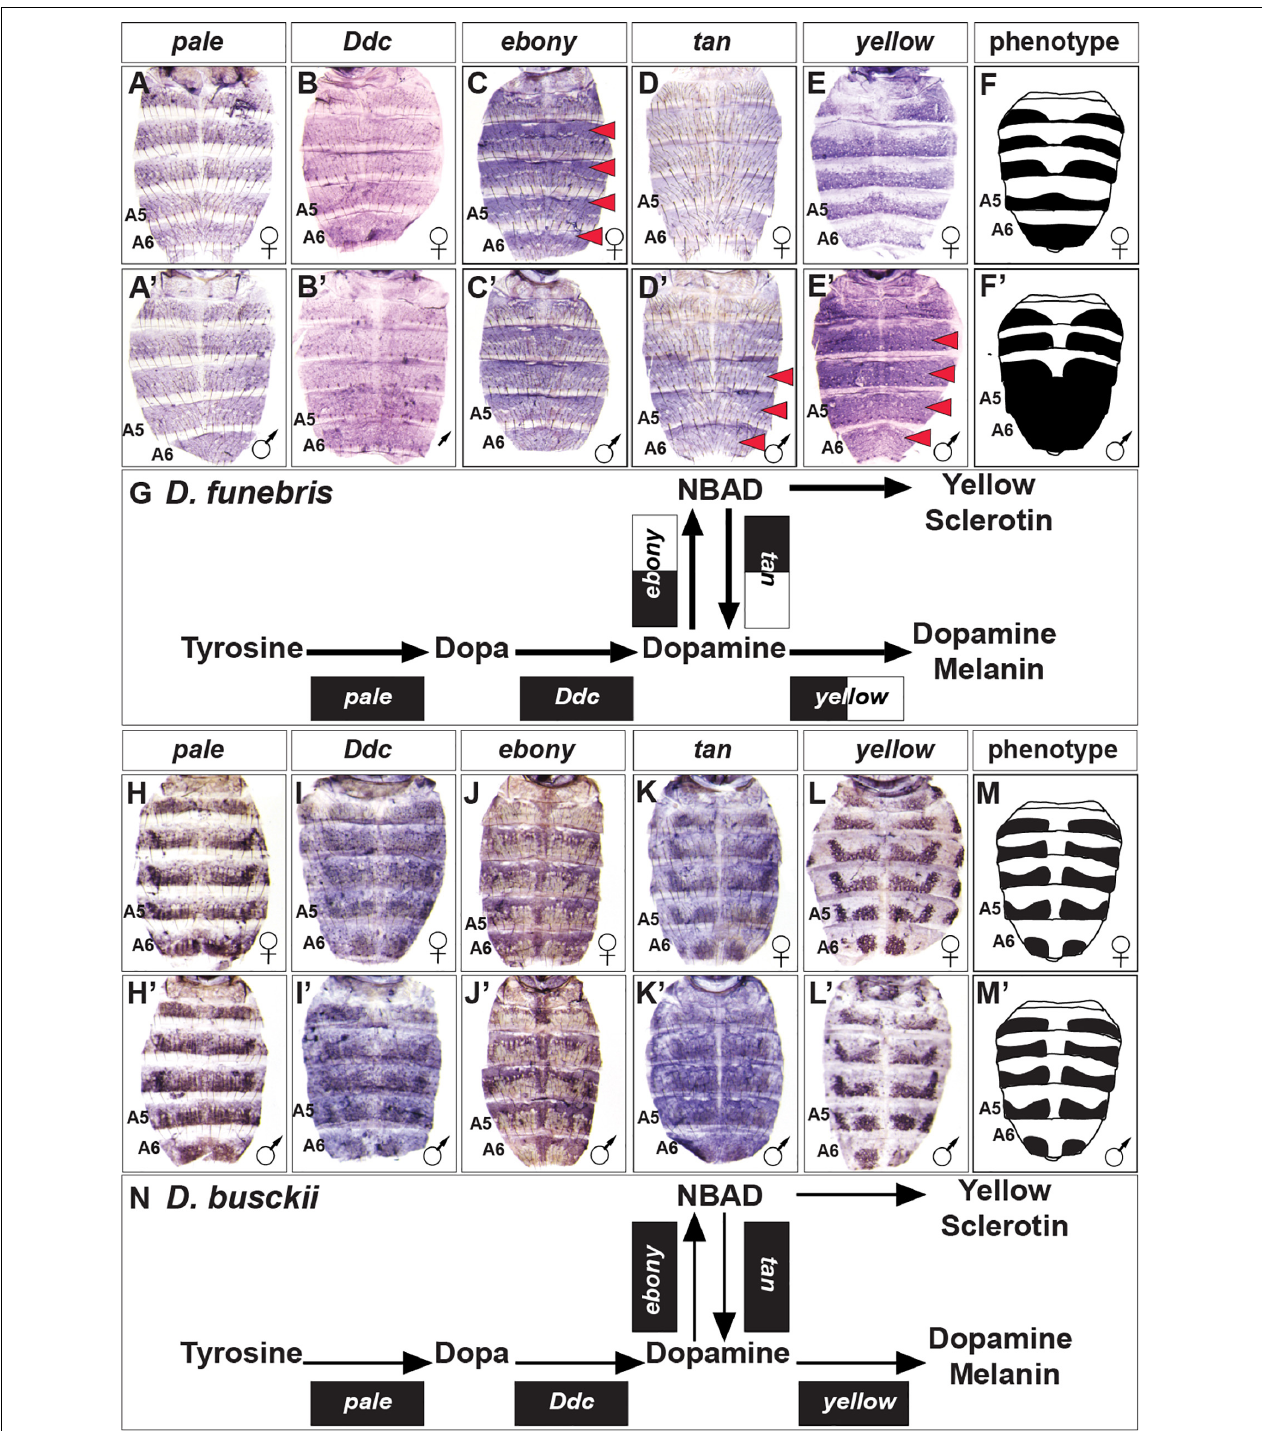
FIGURE 6 | Contrast in the pigment metabolic pathway utilization between the dimorphic D. funebris and the monomorphic D. busckii . (A–E) Female and (A’–E’) male expressions of D. funebris pigment metabolic pathway genes, and (F,F’) cartoon representation of the pigmentation phenotype. (G) Summary of the D. funebris pathway use includes robust expression of all genes, with dimorphic expressions of ebony , tan , and yellow . (H–L) Female and (H’–L’) male expressions of D. busckii pigment metabolic pathway genes, and (M,M’) cartoon representation of the pigmentation phenotype. (N) Summary of the D. busckii pathway use includes robust and monomorphic expression of all genes. (A,A’,H,H’) pale , (B,B’,I,I’) Ddc , (C,C’,J,J’) ebony , (D,D’,K,K’) tan , and (E,E’,L,L’) yellow . Red arrowheads indicate robust patterns of dimorphic expression in the dorsal abdominal epidermis. (G,N) Black arrow thickness represents the level of expression for the underlying gene. Monomorphic gene expression is represented by the gene names being placed upon a black rectangle. Dimorphic gene expression is represented by the gene names being placed upon a black and white colored rectangle.